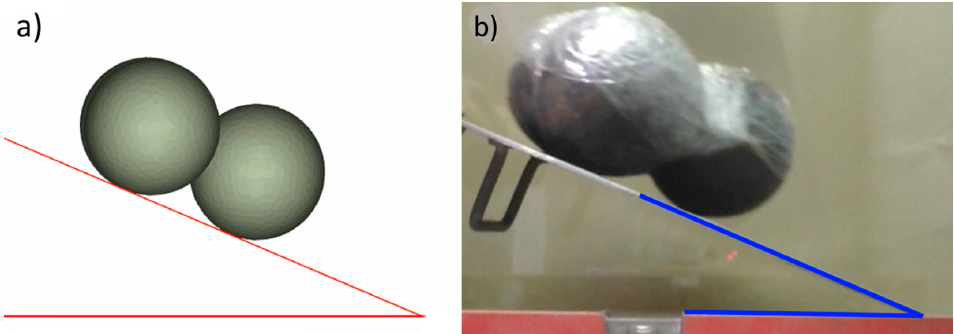
Figure 8. Friction coefficient “steel-steel“ experiment conditions. ( a ) Simulated experiment, ( b ) Laboratory experiment. Table 2. Material interaction coefficients obtained from the calibration tests.